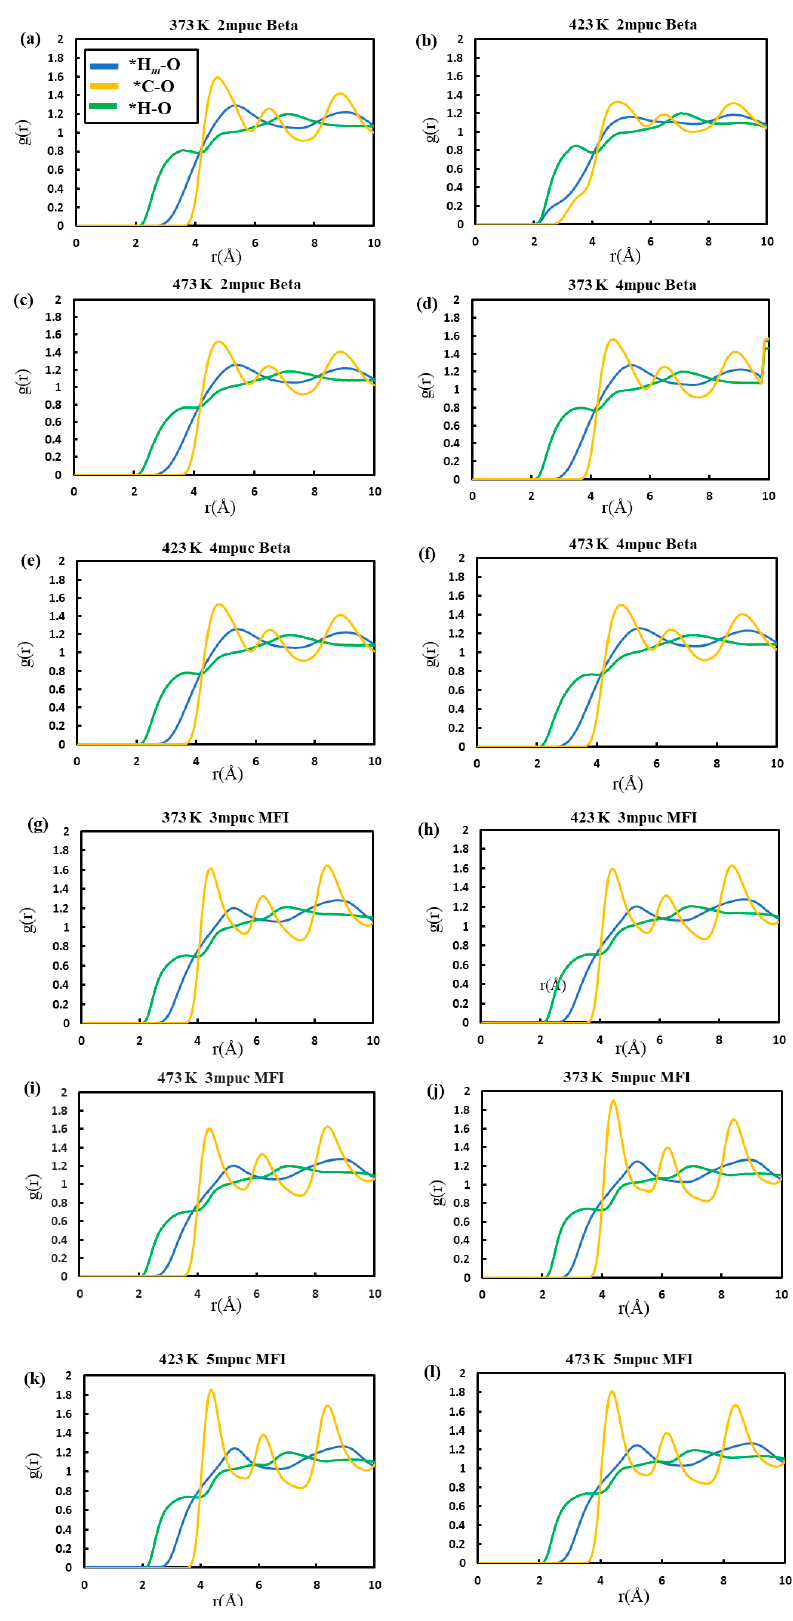
Figure 4. Radial distribution function (RDF) for *H-O, *H m -O, and *C-O in zeolite Beta at loadings of ( a – c ) 2 and ( d – f ) 4 mpuc; and zeolite MFI loadings of ( g – i ) 3 and ( j – l ) 5 mpuc at the temperatures 373, 423, and 473 K.